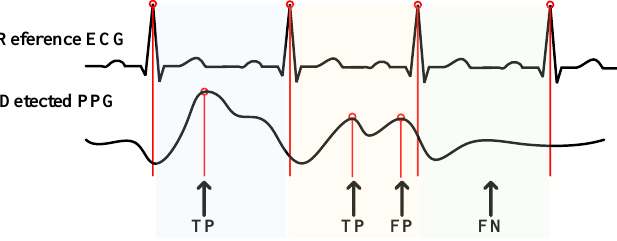
Figure 6. Definition of TP (True Positive), FP (False Positive), and FN (False Negative). Adapted from [24]. Different parameter presents different meaning: the higher the Se , the lower probability of the peaks non-detected; + P represents the ratio of true peaks detected, which means the correctness of the detection; and the FDR is the ratio of failure to correction. Otherwise, if high Se and low FDR are evaluated, the detection result is contributed to a high